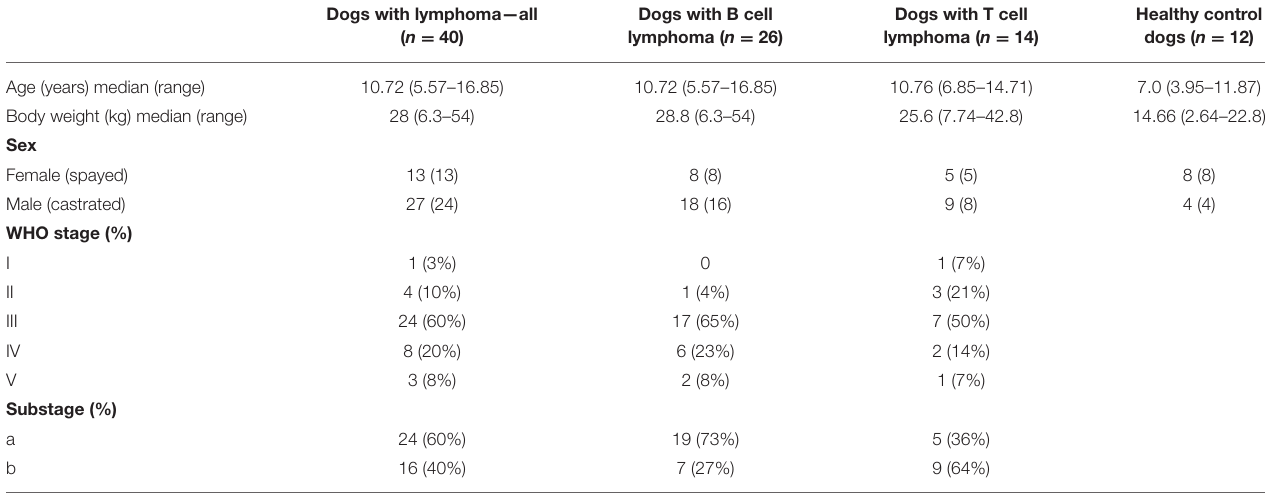
TABLE 1 | Clinical characteristics of dogs with lymphoma and healthy controls.